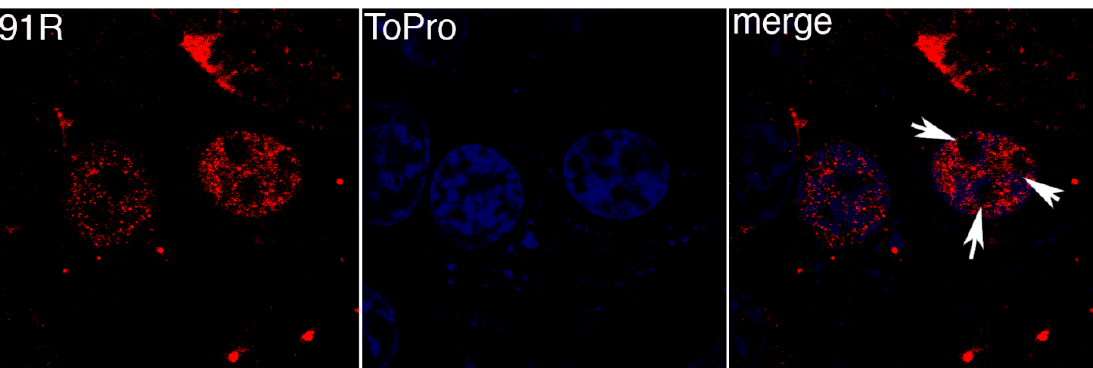
Figure 2. 91R localizes to the nucleus. BGMK cells were transfected with pcDNA3 ‐ 91R ‐ myc. 48 hours post ‐ transfection, the cells were fixed and indirect immunofluorescence was performed using rabbit anti ‐ myc antibodies (red) and TO ‐ PRO ‐ 3 (blue). Images were captured at 100× magnification using a confocal microscope. White arrows highlight nuclear areas that lack 91R and TO ‐ PRO ‐ 3.